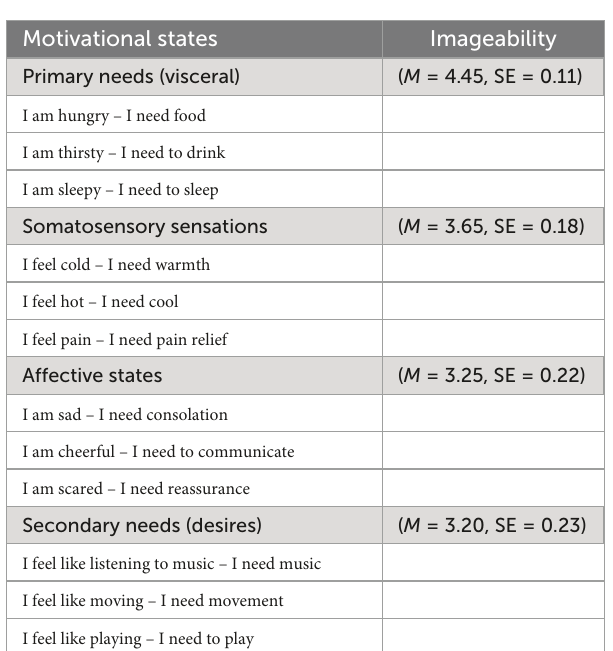
They are reward-related hedonic experience, but, unlike the other needs, sensation and states (Paulus, 2007), they can be inhibited and voluntary suppressed/postponed, which imply a neocortical